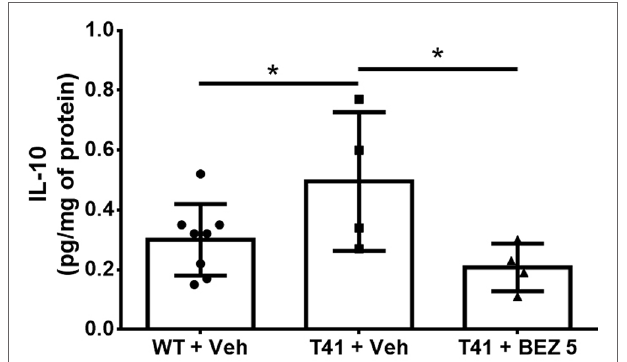
fIGURE 4 | Effects of BEZ treatment on mice hippocampal IL-10 levels. Bar graph represent the quantification of the effect of BEZ treatment on IL-10 levels in the hippocampus. WT + Vehicle (n = 11), T41 + vehicle (n = 6), and T41 + BEZ 5 (n = 5). *p < 0.05 (ANOVA followed by Newman-Keuls